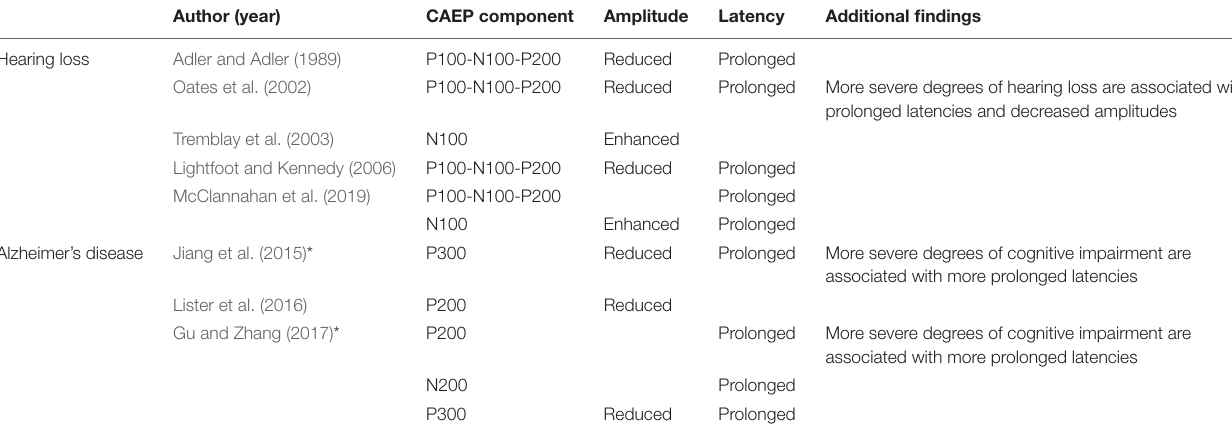
TABLE 1 | Overview of the most relevant findings concerning CAEPs in hearing loss and Alzheimer’s disease.